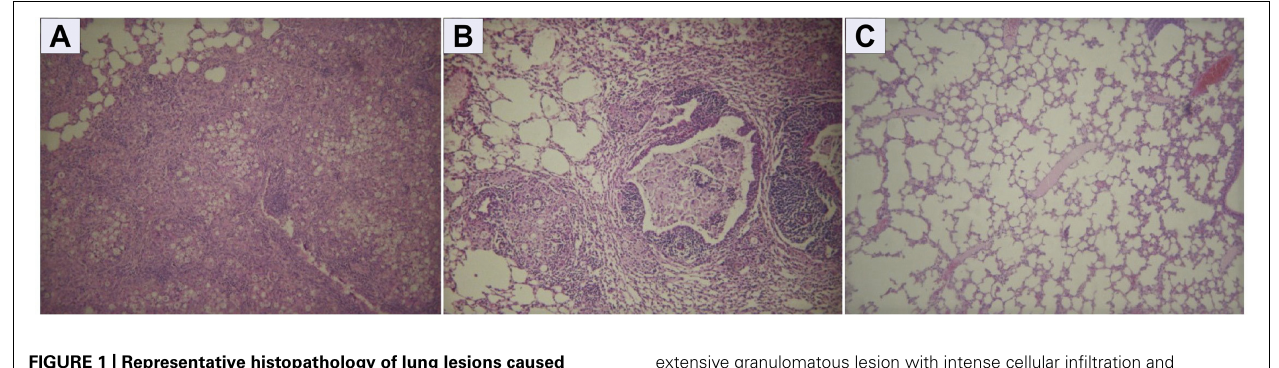
FIGURE 1 | Representative histopathology of lung lesions caused by P. brasiliensis Pb18 strain in mice immunized with P10 in presence of Freund’s complete adjuvant (CFA). Tissue samples were collected two months after i.t. challenge with the Pb18 strain. (A) Lung section from infected mouse, with a granuloma containing multiple viable fungal cells; (B) Lung section from mouse treated with CFA, showing the